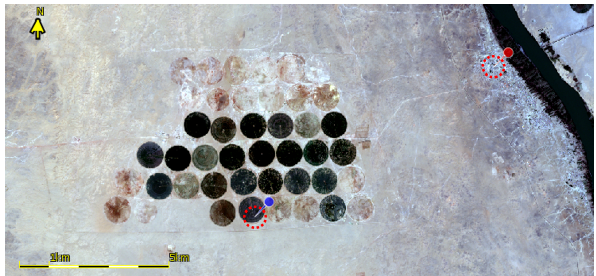
Figure A5. ©Copernicus data (2019). Sentinel-2 natural colour composite showing two anthropogenic dust sources in Sudan. The agricul- tural dust source (blue pin) emitted dust on 21 February 2016. The location of the blue pin is latitude 18.7989, longitude 30.4026. The village dust source (red pin) emitted dust on 26 January 2016. The location of the red pin is latitude 18.8448, longitude 30.4776. A 750m buffer included in red. Background: European Space Agency Copernicus Sentinel-2 data 2018. Sentinel-2 data are provided under the terms and conditions prescribed by the European Commission’s Copernicus Programme. For detailed information on the data policy, appropriate us- age, and citation of Sentinel data, please see: https://scihub.copernicus.eu/twiki/pub/SciHubWebPortal/TermsConditions/TC_Sentinel_Data_ 31072014.pdf (last access: July